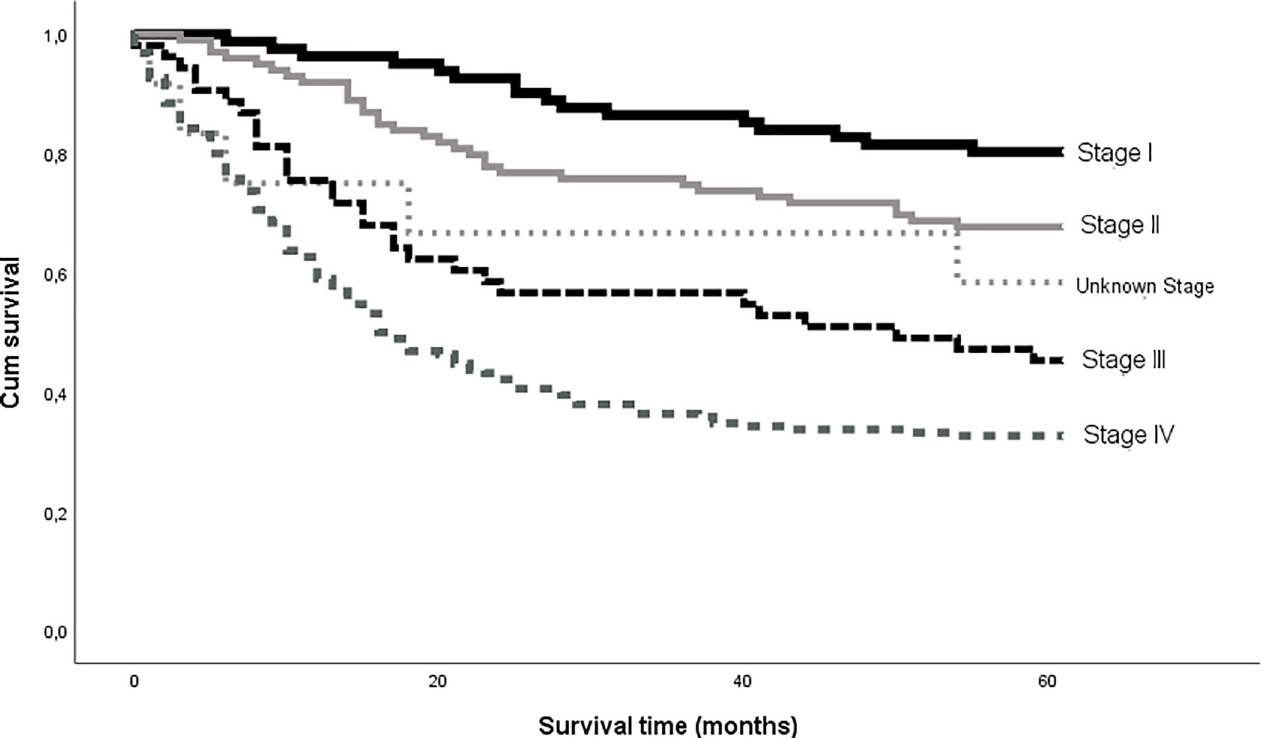
Fig 2. Kaplan-Meier curves show five-year disease-specific survival by stage in 435 patients diagnosed with primary treatment-na ï ve oral cavity squamous cell carcinoma in Norway in the years of 2005–2009.